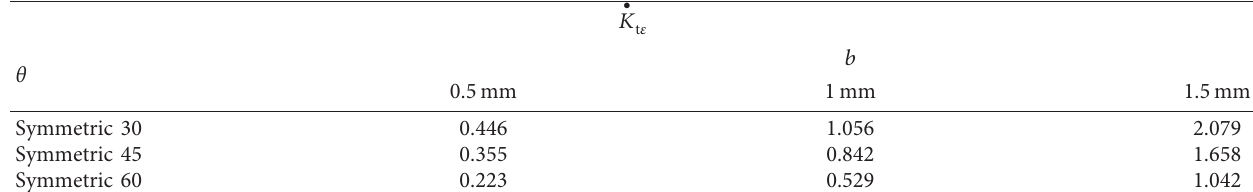
Figure 4: Mises stress figures of different notch opening angles: (a) symmetric 30, (b) symmetric 45, (c) symmetric 60, (d) symmetric U, (e) asymmetric 30, (f) asymmetric 45, (g) asymmetric 60, and (h) asymmetric U. Table 5: Strain rate concentration factor at different notch